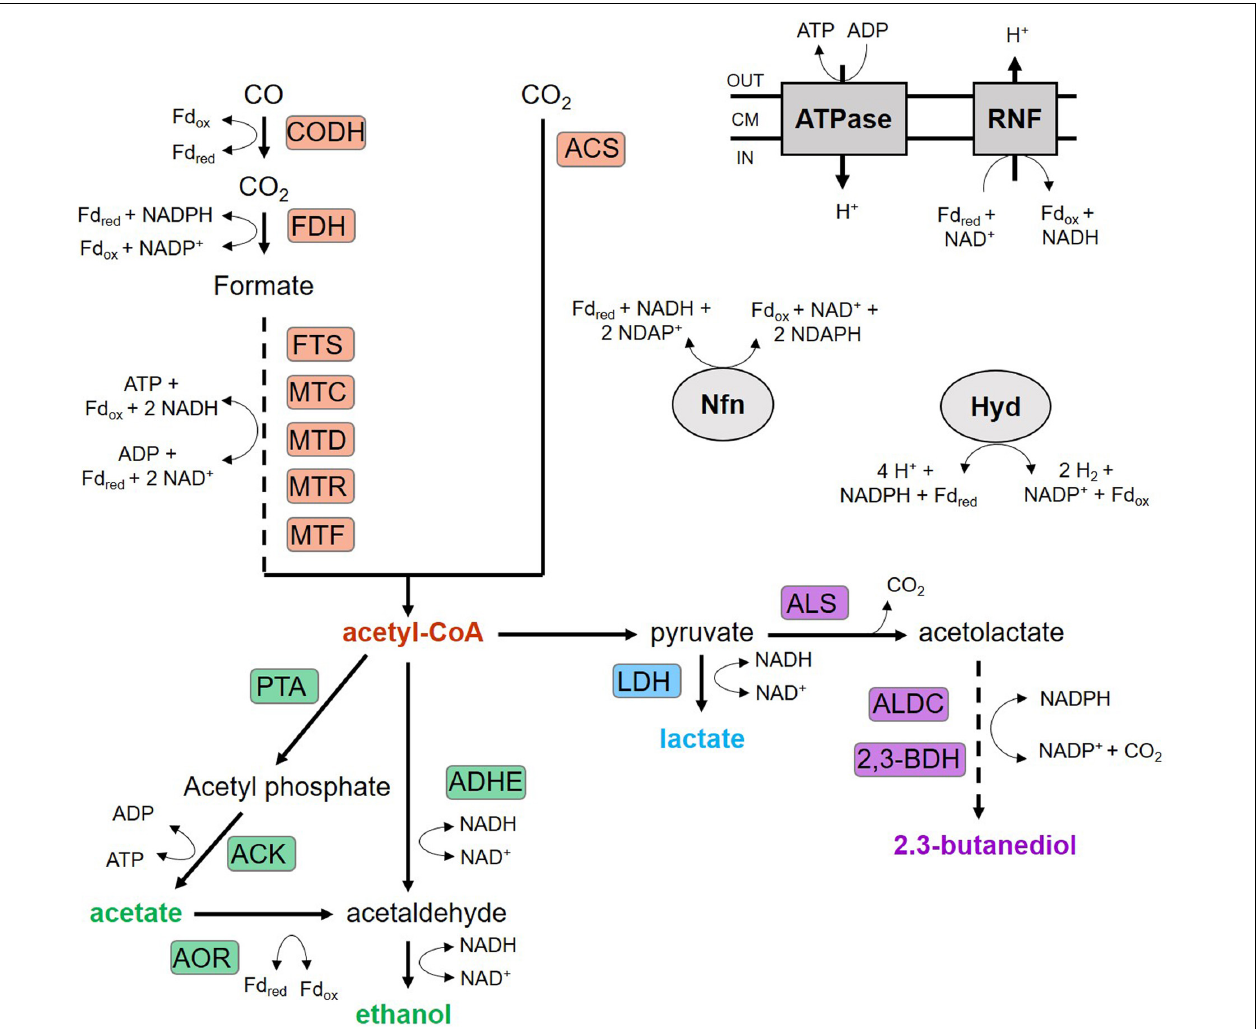
FIGURE 1 | Wood-Ljungdahl pathway and product formation of C. ljungdahlii . ACK, acetate kinase; ACS, acetyl-CoA synthase; ADHE, aldehyde/alcohol dehydrogenase; ALDC, acetolactate decarboxylase; ALS, acetolactate synthase; AOR, aldehyde:ferredoxin oxidoreductase; CODH, CO dehydrogenase; FDH, formate dehydrogenase; FTS, formyl-THF synthetase; Hyd, electron-bifurcation hydrogenase; LDH, lactate dehydrogenase; MTC, methenyl-THF cyclohydrolase; MTD, methylene-THF dehydrogenase; MTF, methyltransferase; MTR, methylene-THF reductase; Nfn, electron-bifurcating and ferredoxin-dependent transhydrogenase; PFOR, pyruvate:ferredoxin oxidoreductase; PTA, phosphotransacetylase; PTF, phosphotransferase; RNF, Rnf complex; THF, tetrahydrofolate; 2,3-BDH: 2,3-butanediol